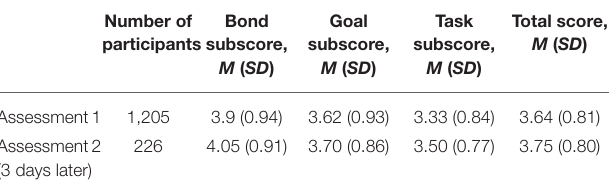
TABLE 2 | Subscale level descriptive statistics across cohorts and